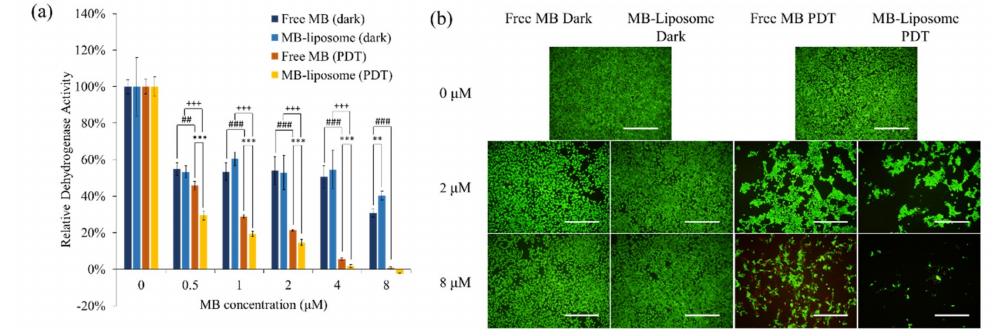
Figure 4. ( a ) The 24-h cell viability (by MTT assay) of free MB and MB-liposomes at different concentrations with dark treatment or photodynamic therapy (PDT) treatment. ( n = 4, **: p < 0.01, ***: p < 0.001 comparison between free MB and MB liposome at same concentration of free MB. ##: p < 0.01, ###: p < 0.001 comparison between dark and PDT treatment at same concentration of free MB. +++: p < 0.001 comparison between dark and PDT treatment at same concentration of MB-liposome). ( b ) Live and dead staining after 24 h treatment of free MB and MB-liposomes. Green, calcium acetoxymethyl (AM); Red, PI; Scale bar, 500 µ